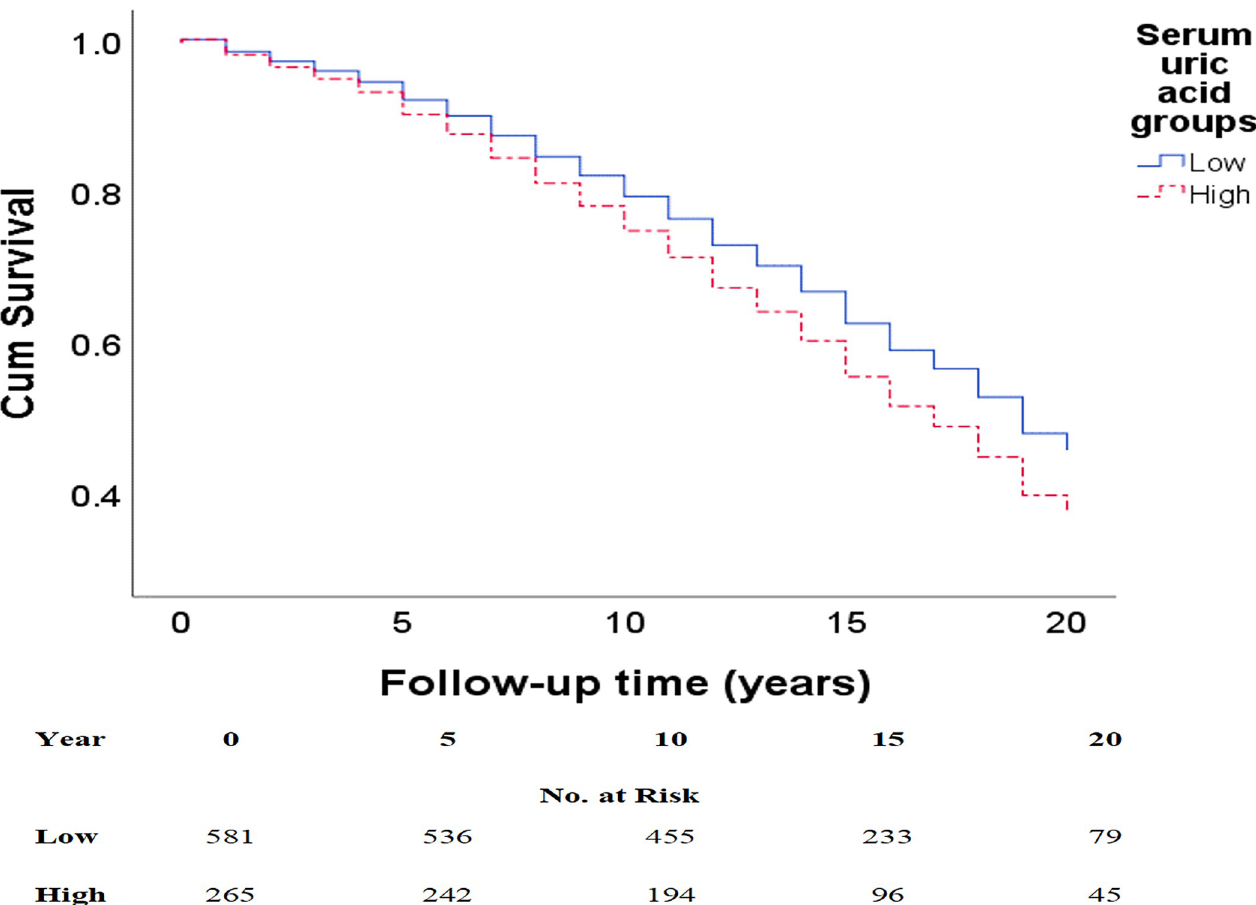
Fig 2. Adjusted a Cox regression survival curves according to serum uric acid tertiles for all-cause mortality. a Adjusted for age and sex. Mean survival time for all-cause mortality in the low SUA tertiles (T1-2) was 15.3 (95%CI, 14.8–15.8) years and 14.3 (95%CI, 13.5–14.7) years in the upper SUA tertile (T3), p = 0.03. * Please note that the y-axis doesn’t reach zero.